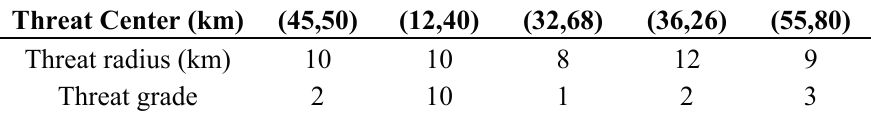
Table 8. Information about known threats for the first test